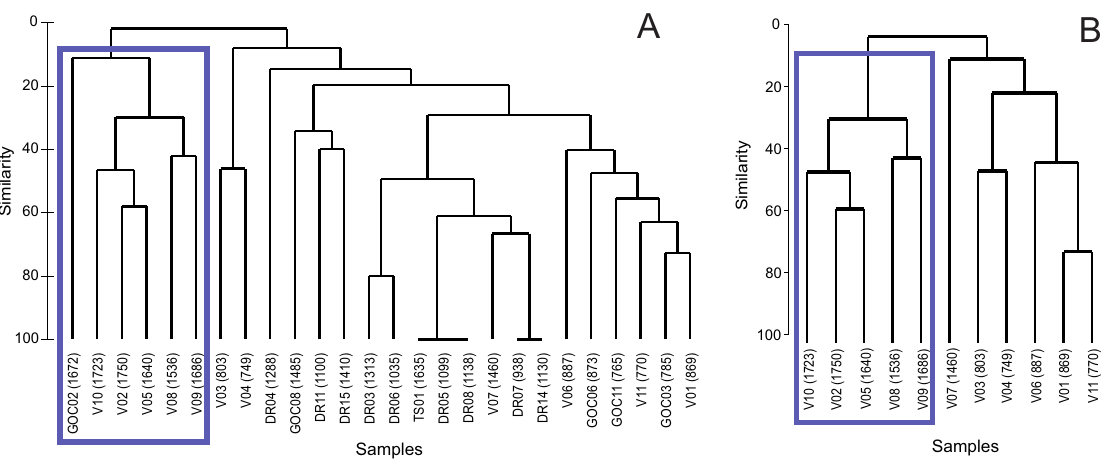
Fig. 45. Similarity between samples from the BANGAL 0711 campaign, based on presence/absence data of living specimens for molluscan species and on the Bray-Curtis similarity index (A, all samples; B, beam trawl samples only). Sample labels with depth in brackets. A similar topology was obtained using the abundance data transformed to fourth